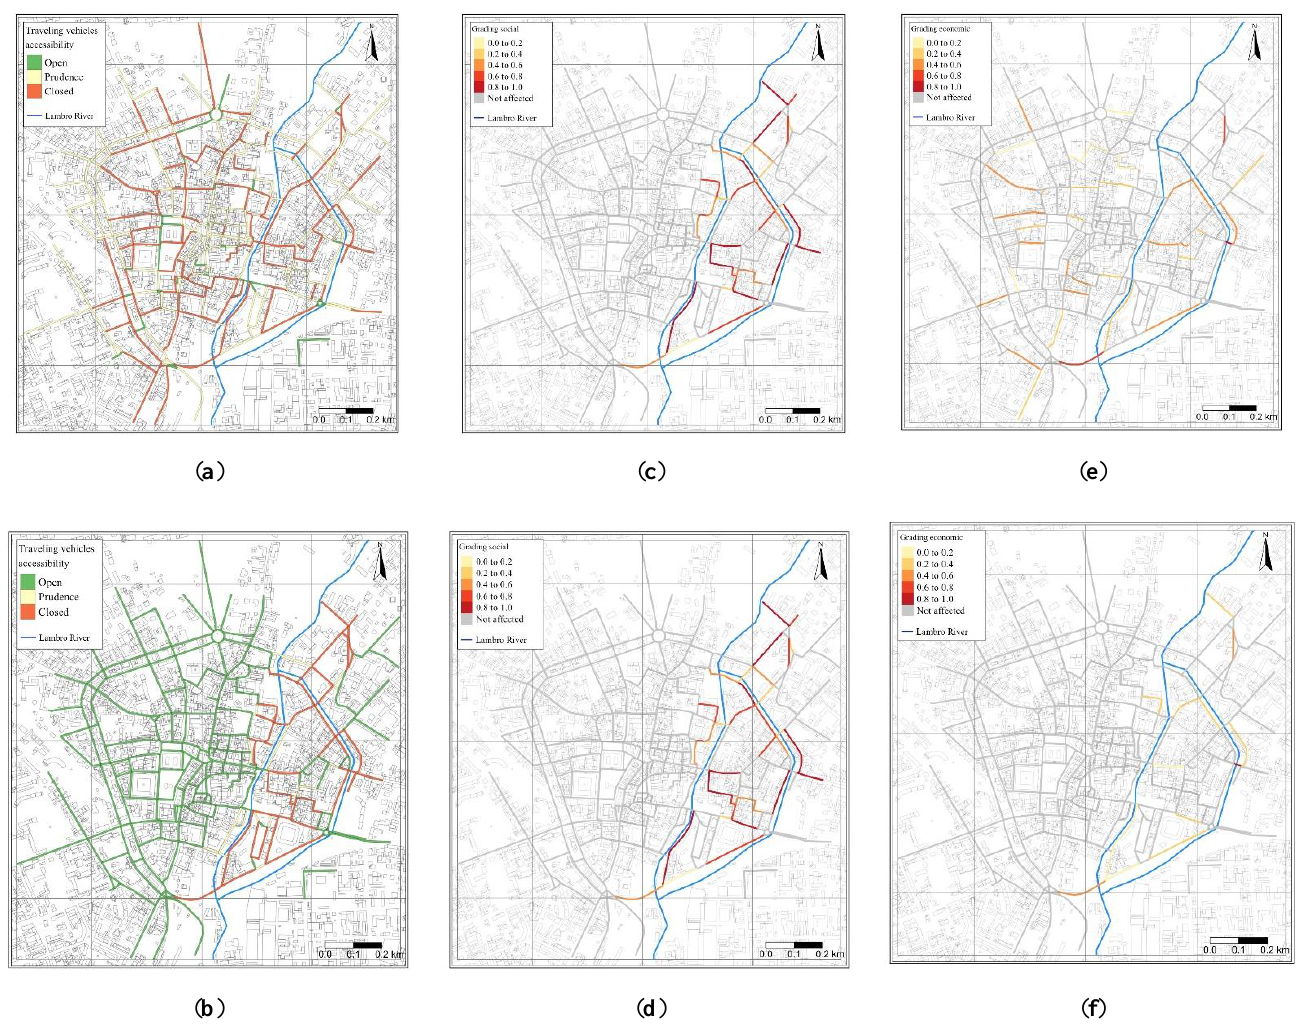
Figure 5. Comparison between pluvial ( a , c , d ) and fluvial ( b , d , f ) hazards at T = 100yy scenario: ( a , b ) traveling vehicles accessibility; ( c , d ) social service impact; ( e , f ) economic service impact.